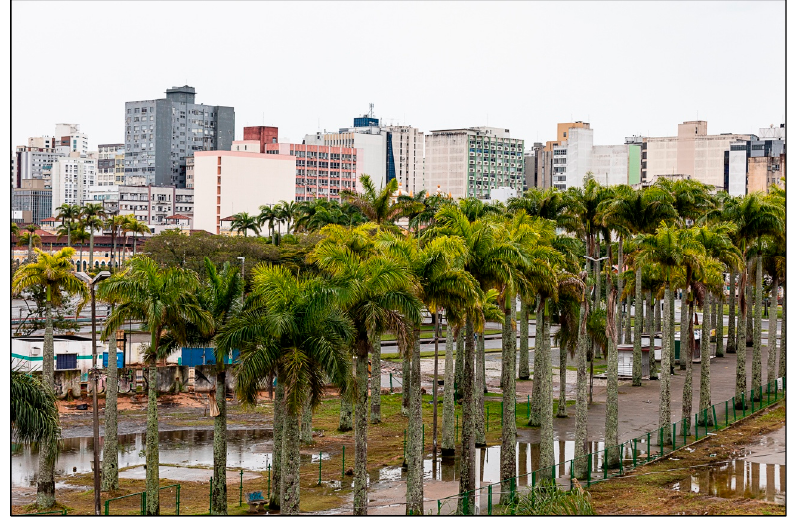
Figure 6. A view of downtown Florianópolis, reproduced with permission from Eduardo Trauer (photo taken in February 2018).